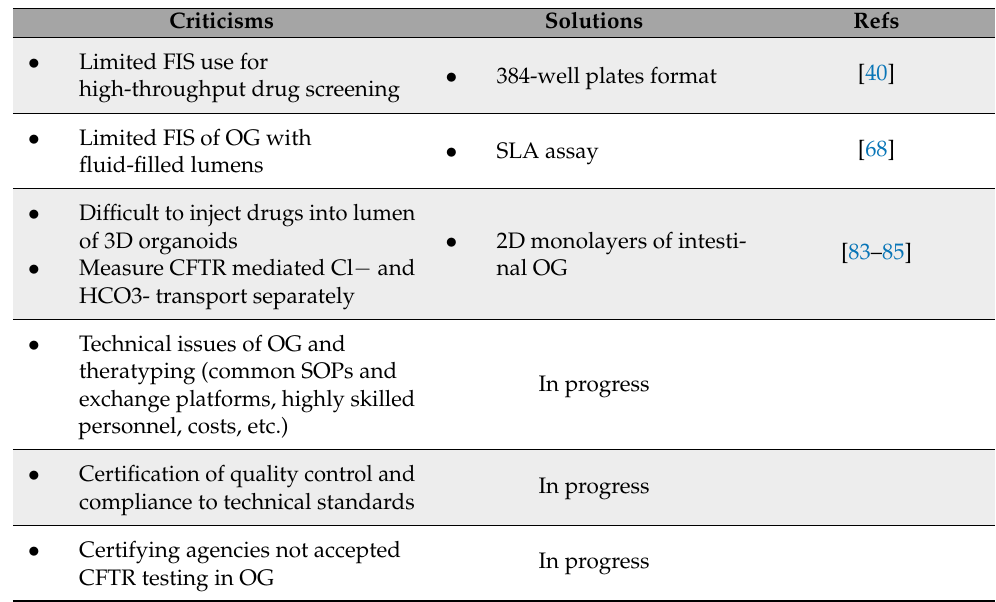
Table 5. Limitations and possible solutions to challenges faced with organoid cultures and theratyp- ing